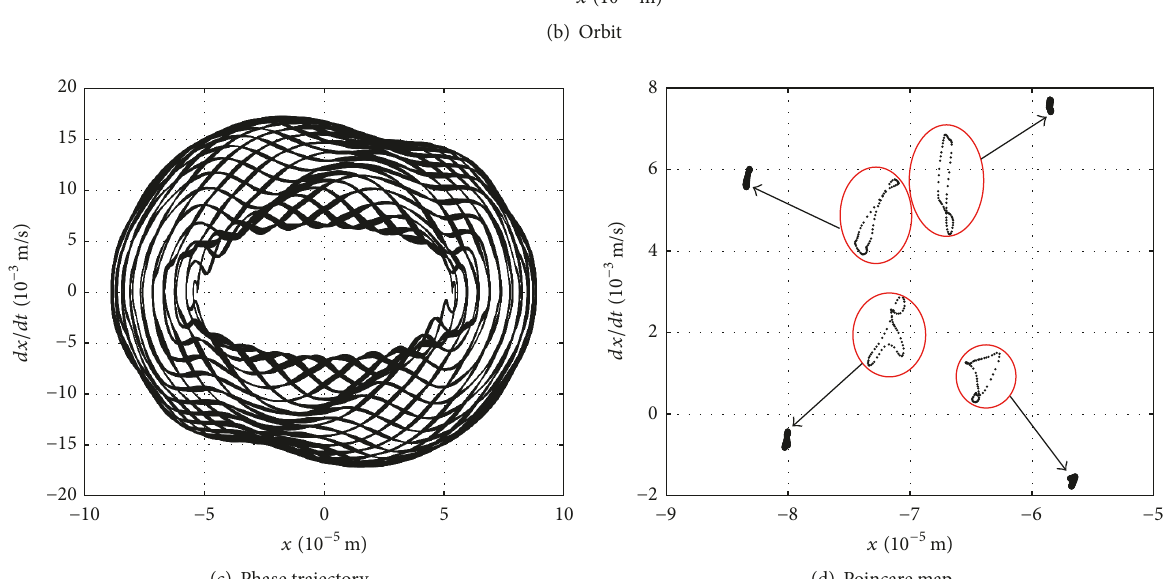
Figure 16: Response analysis of disk 2: 𝜔 1 = 170 rad / s and 𝜆 = −1.65